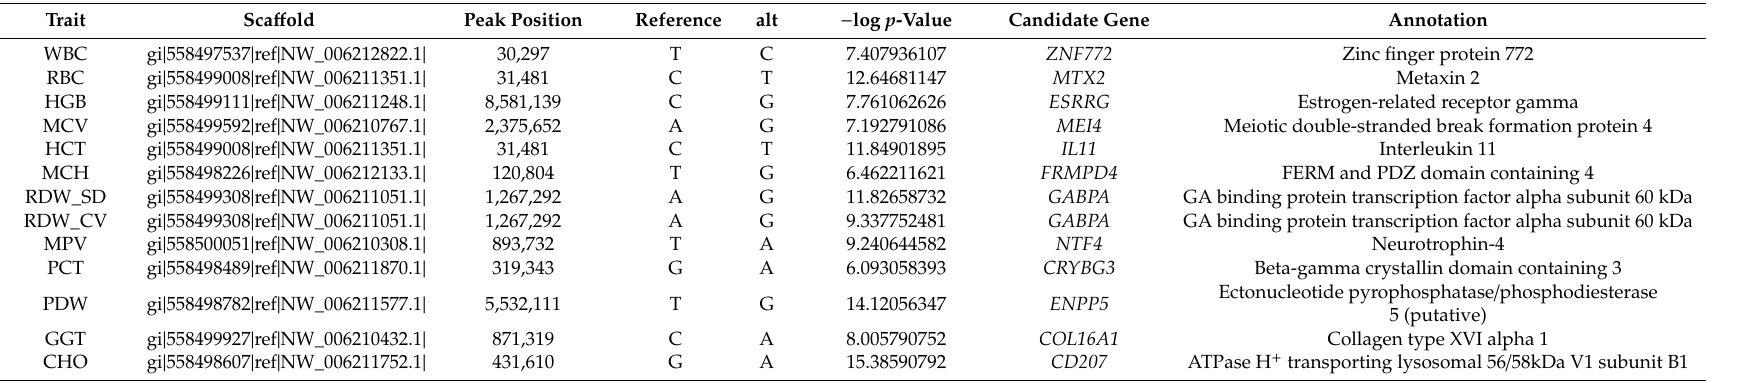
Table 3. Potential candidate genes identified by the genome-wide association study (GWAS) and based on genome annotations for the wild Bactrian camel. Trait Sca ff old Peak